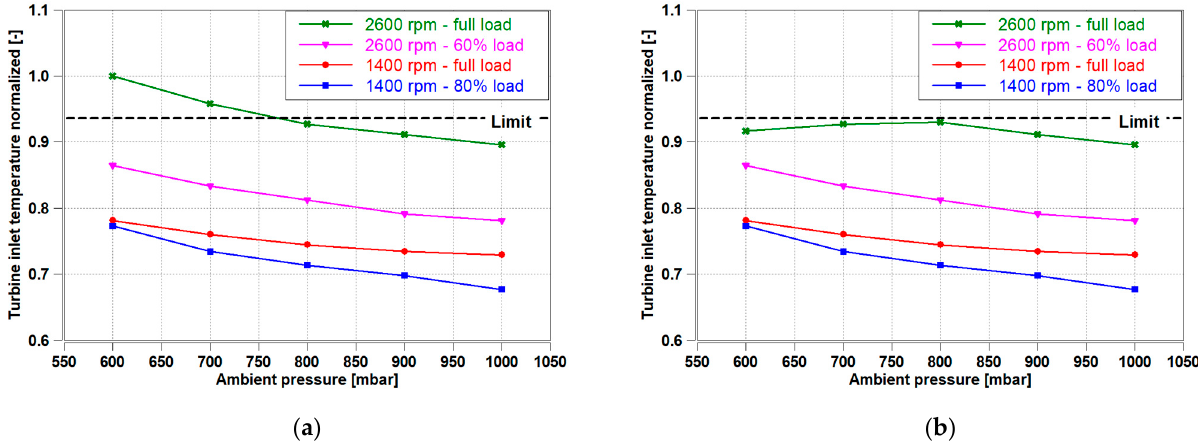
Figure 21. ( a ) Turbine inlet temperature w/o Altitude Calibration normalized with respect to the maximum value reached in the test; ( b ) Turbine inlet temperature w/ Altitude Calibration normalized with respect to the maximum value reached in the test w/o altitude calibration.